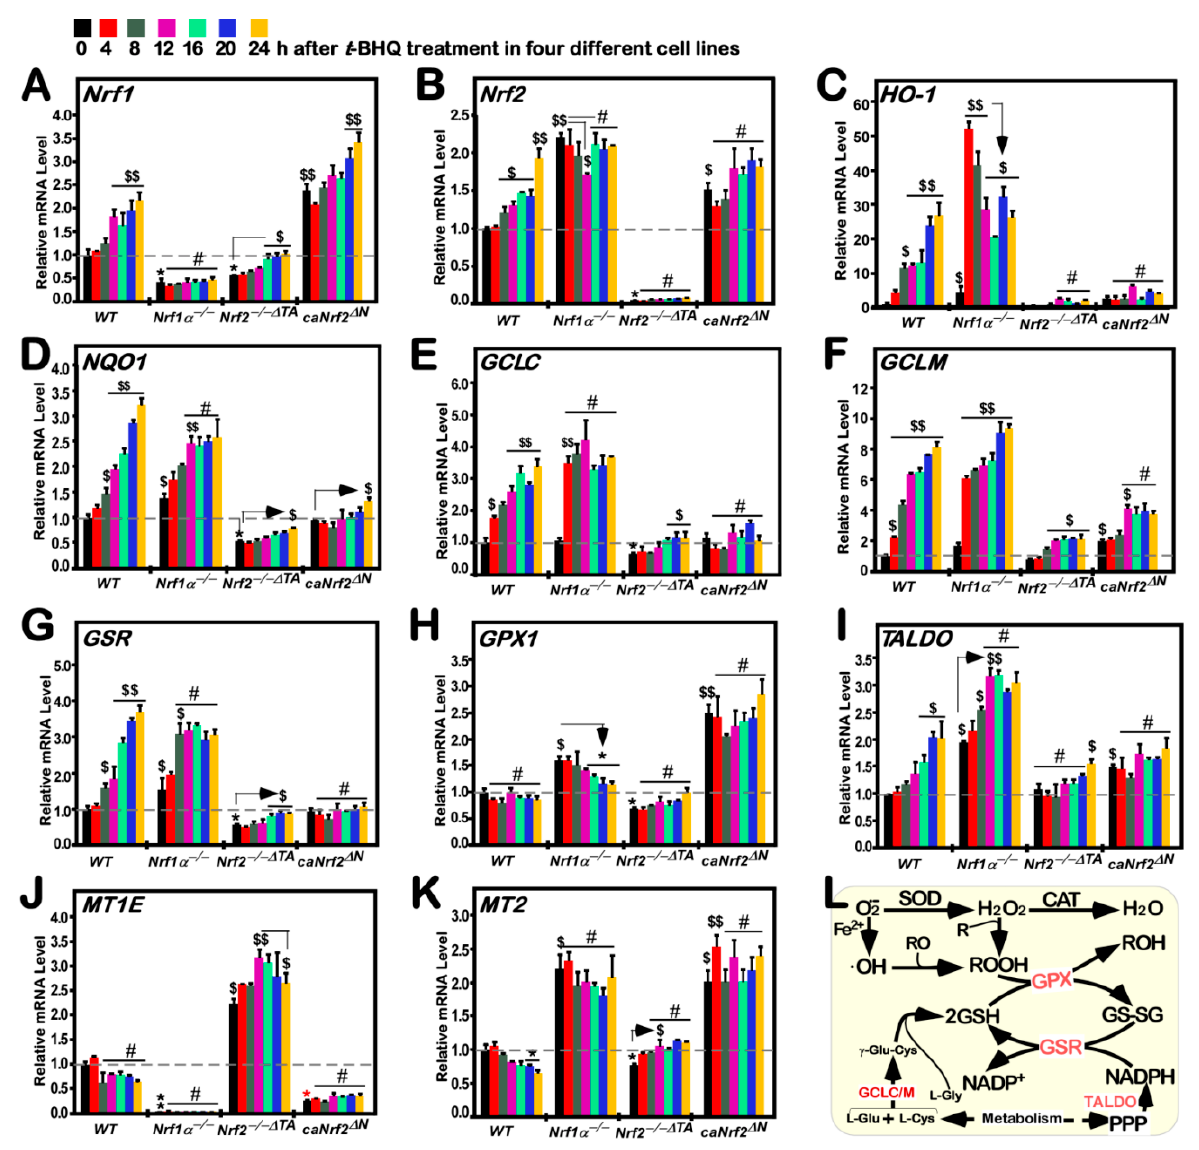
Figure 2. Time-dependent changes in the mRNA expression of distinctive responsive genes to tBHQ. Distinct genotypic cell lines of WT , Nrf1 α − / − , Nrf2 − / −Δ TA or caNrf2 Δ N were (or were not) treated with 50 μ M t BHQ for 0 to 24 h, before both basal and t BHQ-inducible mRNA expression levels of all examined genes were determined by RT-qPCR. ( A – K ) These genes included Nrf1 ( A ), Nrf2 ( B ), HO-1 ( C ), NQO1 ( D ), GCLC ( E ), GCLM ( F ), GSR ( G ), GPX1 ( H ), TALDO ( I ), MT1E ( J ), and MT2 ( K ). Then, mRNA expression was calculated as described in “Section 2”. The resulting data were shown as fold changes (mean ± SD, n = 3 × 3), which are representative of at least three independent experiments being each performed in triplicates. Significant increases ($, p < 0.05; $$, p < 0.01) and significant decreases ( * p < 0.05; ** p < 0.01), in addition to the non-significance (#), were statistically analyzed when compared with the corresponding cell line controls (measured at 0 h), respectively. ( L ) A schematic representation of several major ROS-scavenging enzymes (e.g., SOD and CAT) and relevant redox signaling (e.g., GPX and GSR) to defend against oxidative stress over-stimulated by ROS along with oxygen free radicals. Of note, as two important antioxidant players, GSH and NADPH are yielded from cell metabolism through key enzymes GCLC/M and TALDO, respectively. Thereby, these key gene products exert their vital redox-regulatory functions in antioxidant, detoxification, and cytoprotective